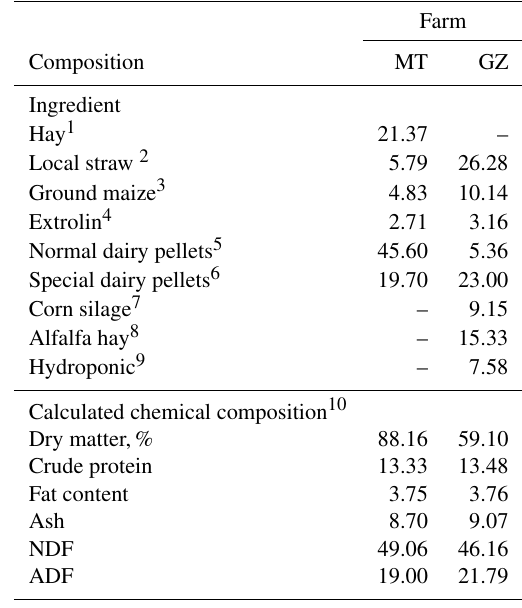
Table 1. Ingredients and chemical composition (% of DM) of Malta (MT) and Gozo (GZ)